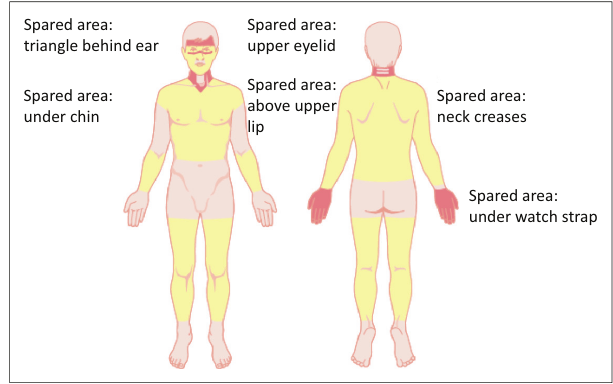
FIGURE 1: Photosensitive